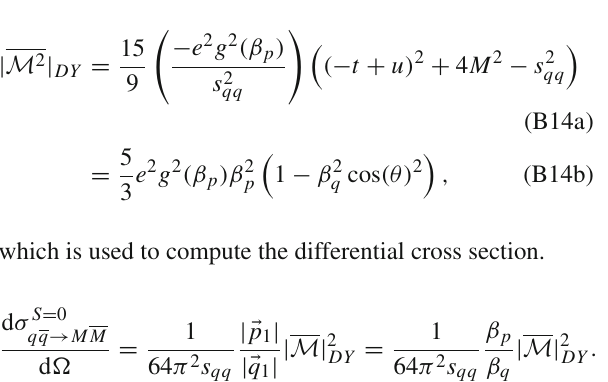
Fig. 31 Interaction vertex representing the only coupling of a spin- 1 / 2 fermion (continuous line), which may be a monopole, and a photon (wavyline)in U ( 1 ) gaugeinvariantquantum-electrodynamics.Thecor- responding Feynman rule is given in